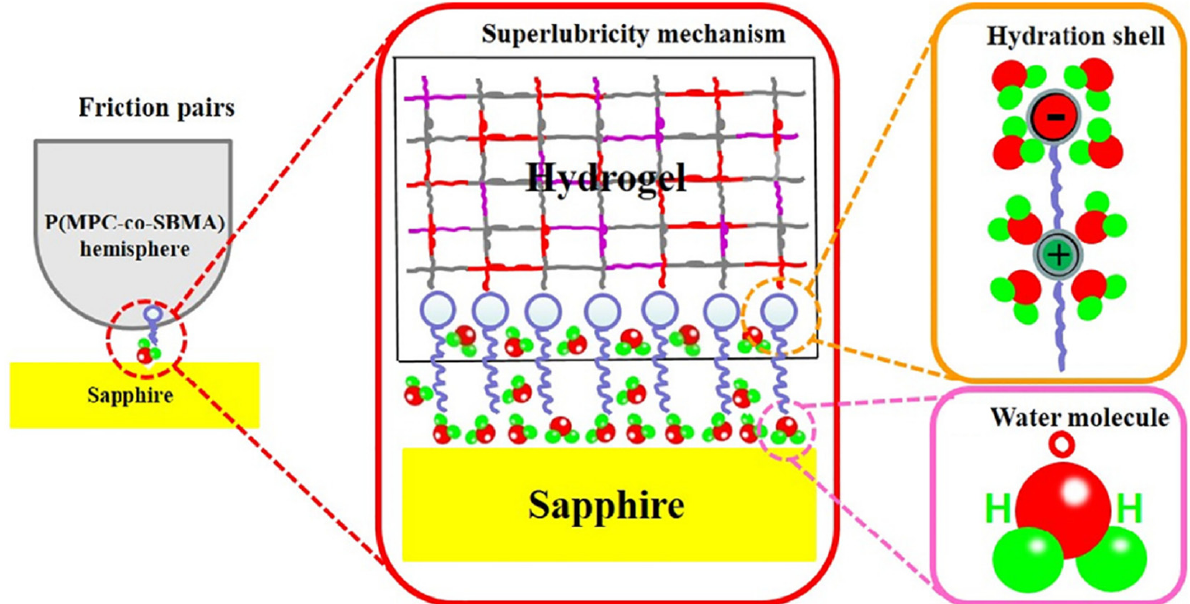
Figure 8. Superlubricity mechanism between P(MPC-co-SBMA) copolymer hydrogel and sapphire. Stabilized hydration layer formation contributed by strong hydration effect of zwitterionic MPC and strong adsorption of water on the sapphire surface. Reproduced with permission from [80] .